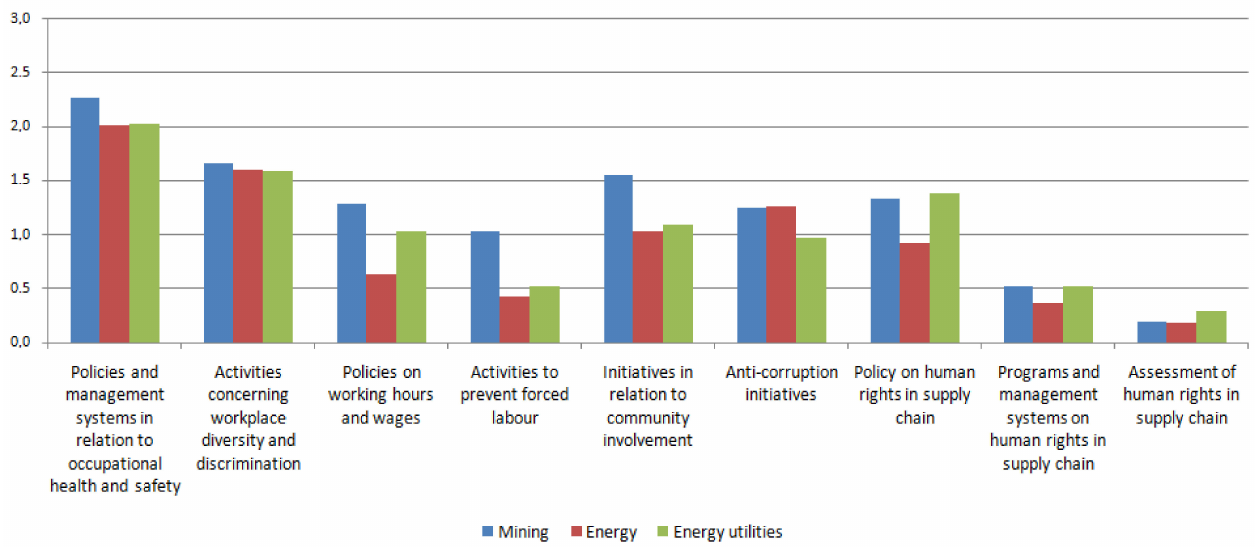
Figure 3. Comparison of mean values of grades obtained in social indicators by mining, energy, and energy utilities